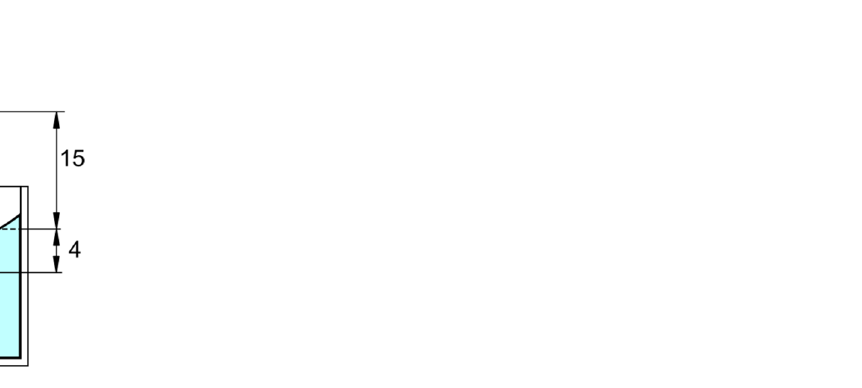
Figure 3. Experimental setup for chemical and biological treatment. The plasma jet impinges on the liquid surface and slightly dives into the liquid.